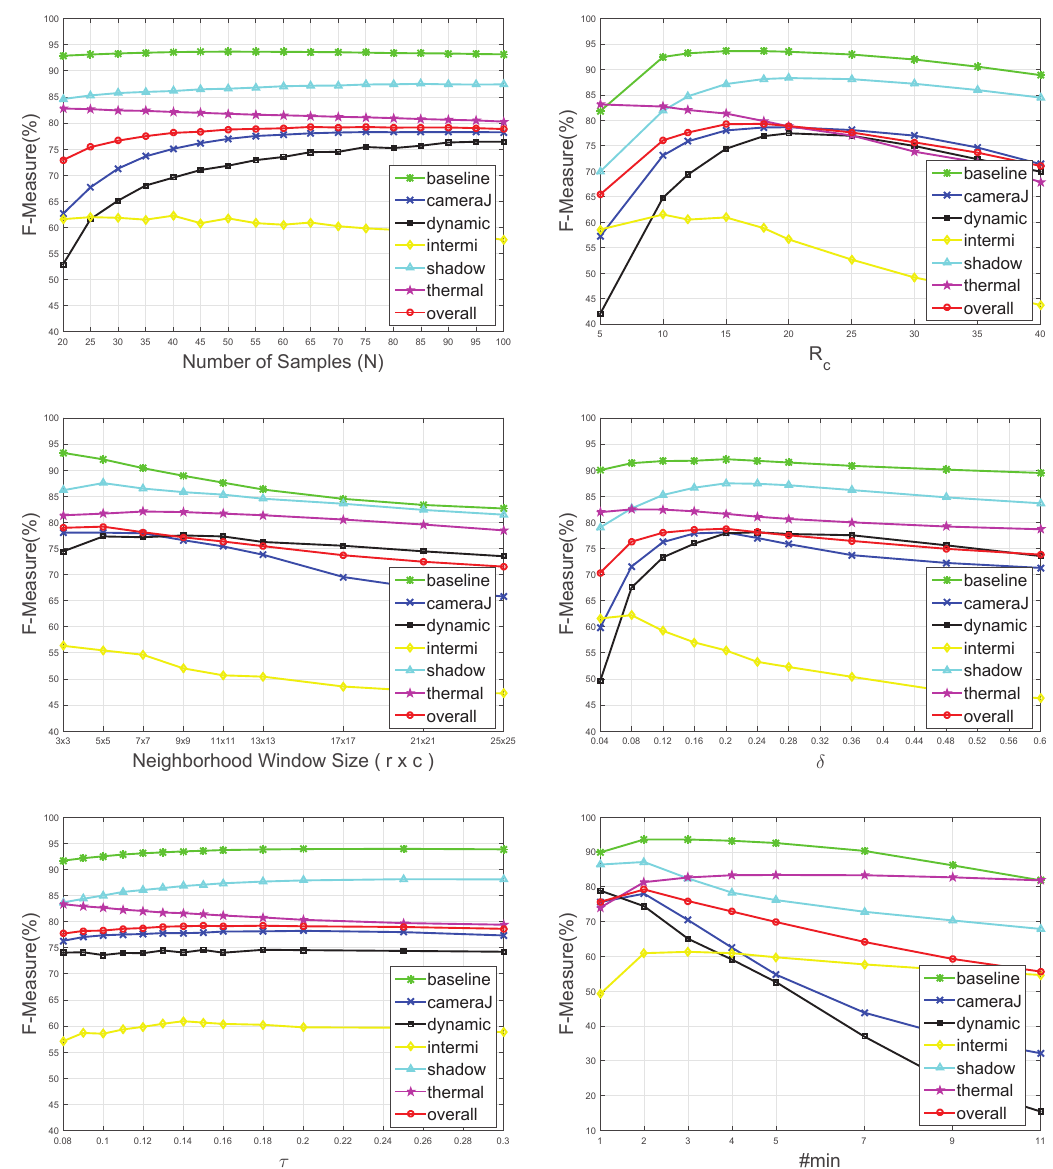
Figure 9. F-Measure of our method on each category as well as overall performance with changing parameter settings. (CDnet2012